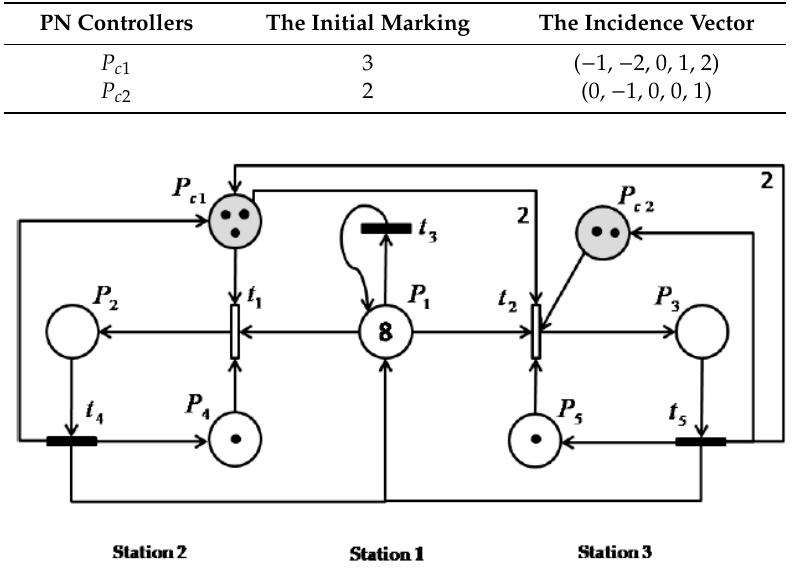
Table 3. The controlled Petri net model of FMS.